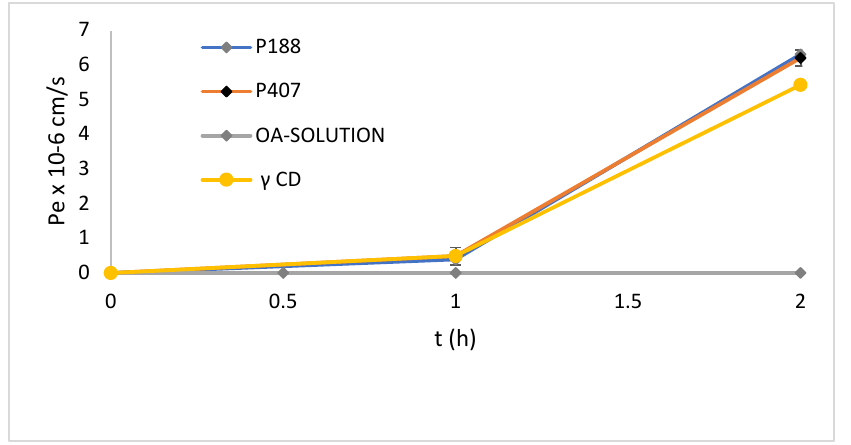
Figure 7. Effective permeability (Pe) of OA, SEM OA-P188 1:2, SEM OA-P407 1:2, and SEM OA- γ - CD1:2. (Data are expressed as mean ± SD of n = 3 experiments.)